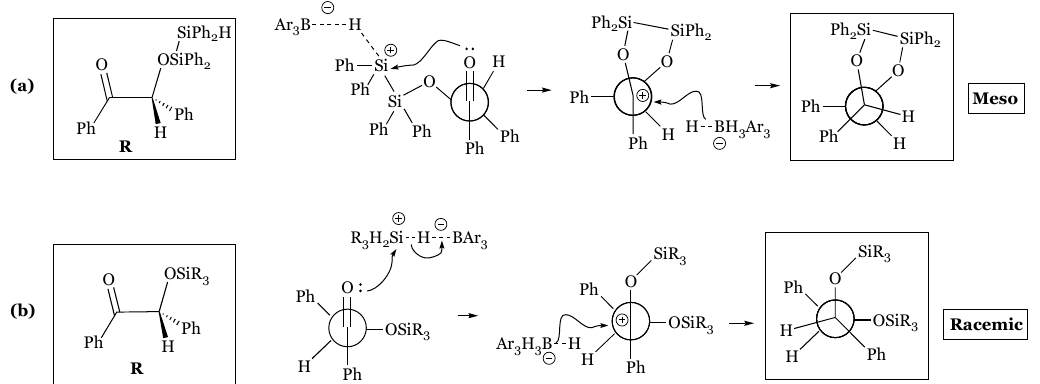
Figure 33. Felkin-Ahn models for second silyl addition with an α -diketone using: ( a ) disilane; ( b ) “large” monosilane placed orthogonal.